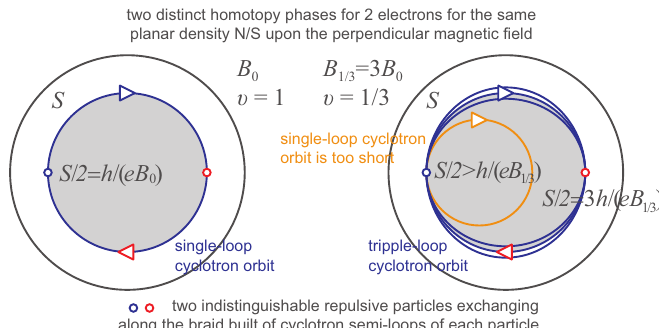
Figure A4. Two electrons at T = 0 K are symmetrically positioned on the circular jellium at the radius ca. 0.7 r , where 2 r is the diameter of the jellium (the simplest Wigner-type distribution). At magnetic fields B 0 (left) corresponding to ν = N the commensurability conditions are fulfilled for single-loop and three-loop orbits, respectively.